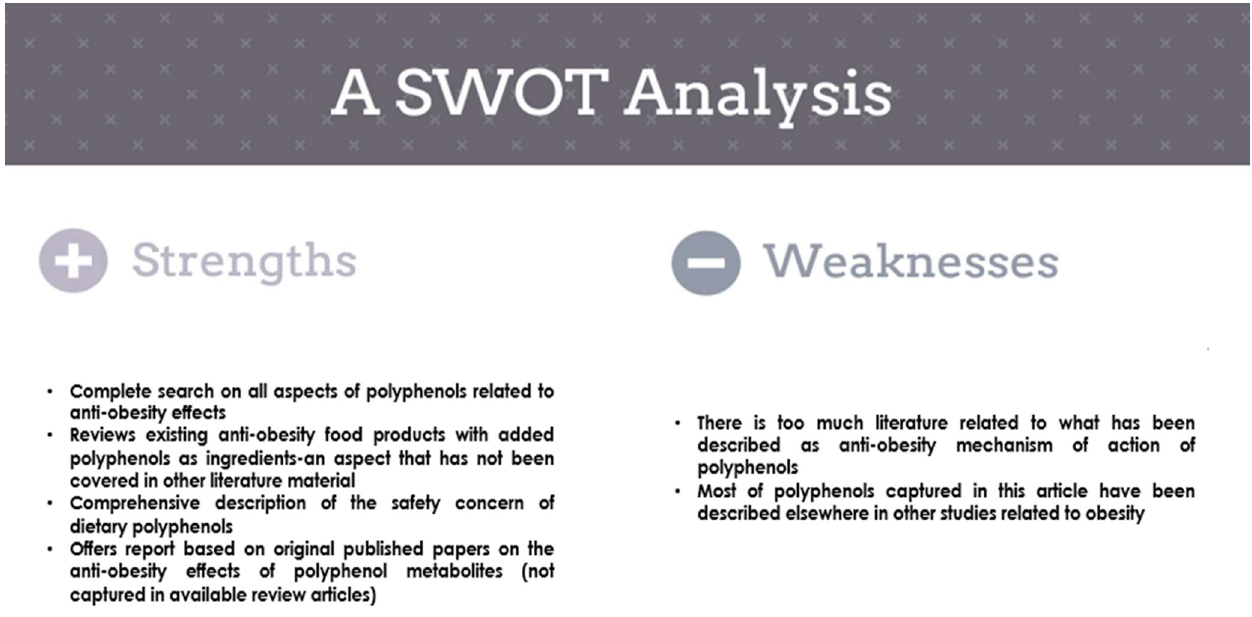
Figure 1. Strengths and weaknesses of the current